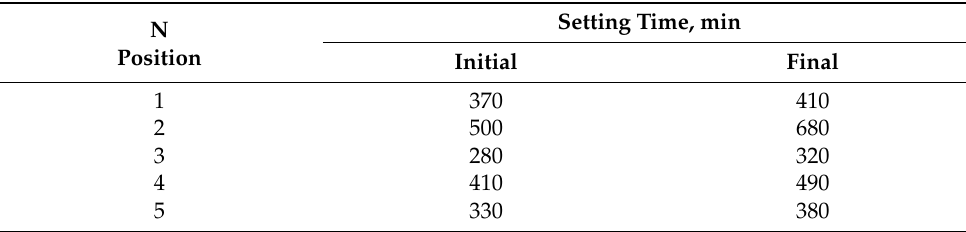
Table 4. Results of the setting times of cement pastes, depending on the method of introducing water